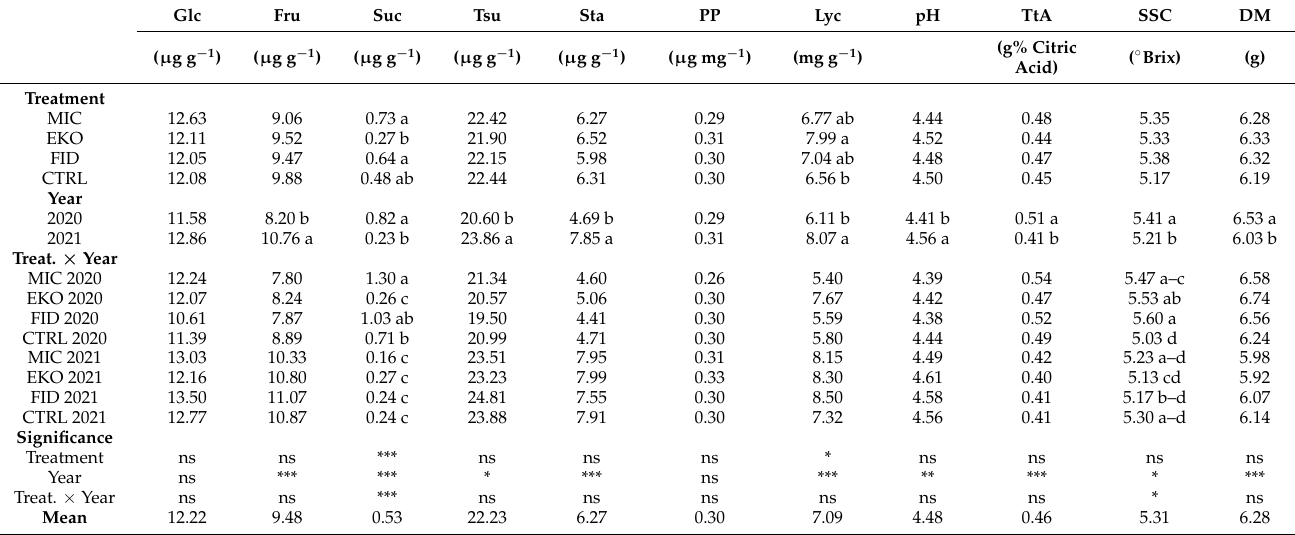
Table 2. Effects of treatments (MIC = Micosat F Tab Plus, EKO = EKOprop NX, FID = Fidelius, CTRL = control), year and treatment × year interaction on chemical and technological characteristics of tomato fruits (cv “Heinz